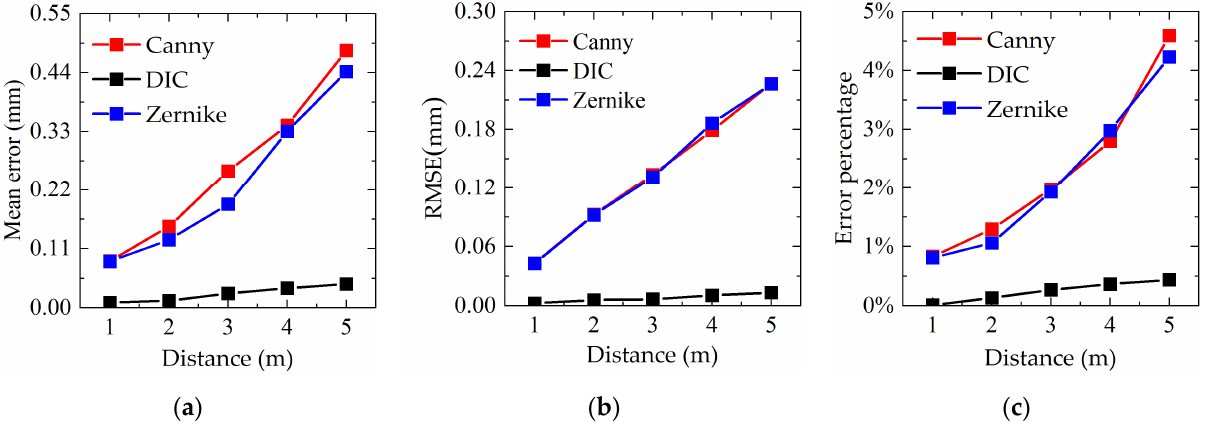
Figure 10. Performance evaluation of laboratory experimental algorithms: ( a ) mean error; ( b ) error variance; and ( c ) variation of error percentage with distance.